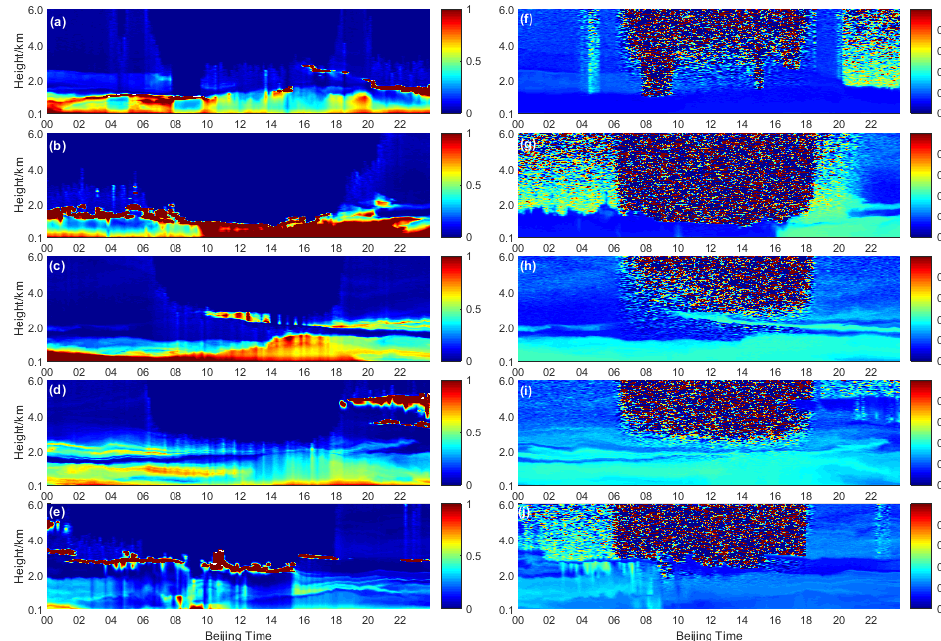
Figure 3. Extinction coefficient ( a – e ) and VDR ( f – j ) from 14 March to 18